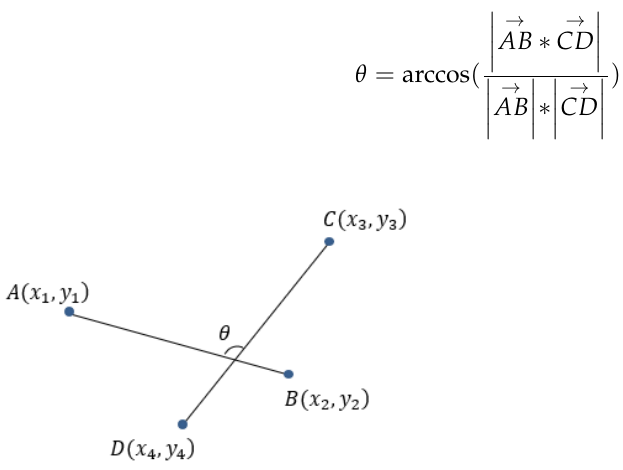
Figure 4. The angle formed by the line segment.